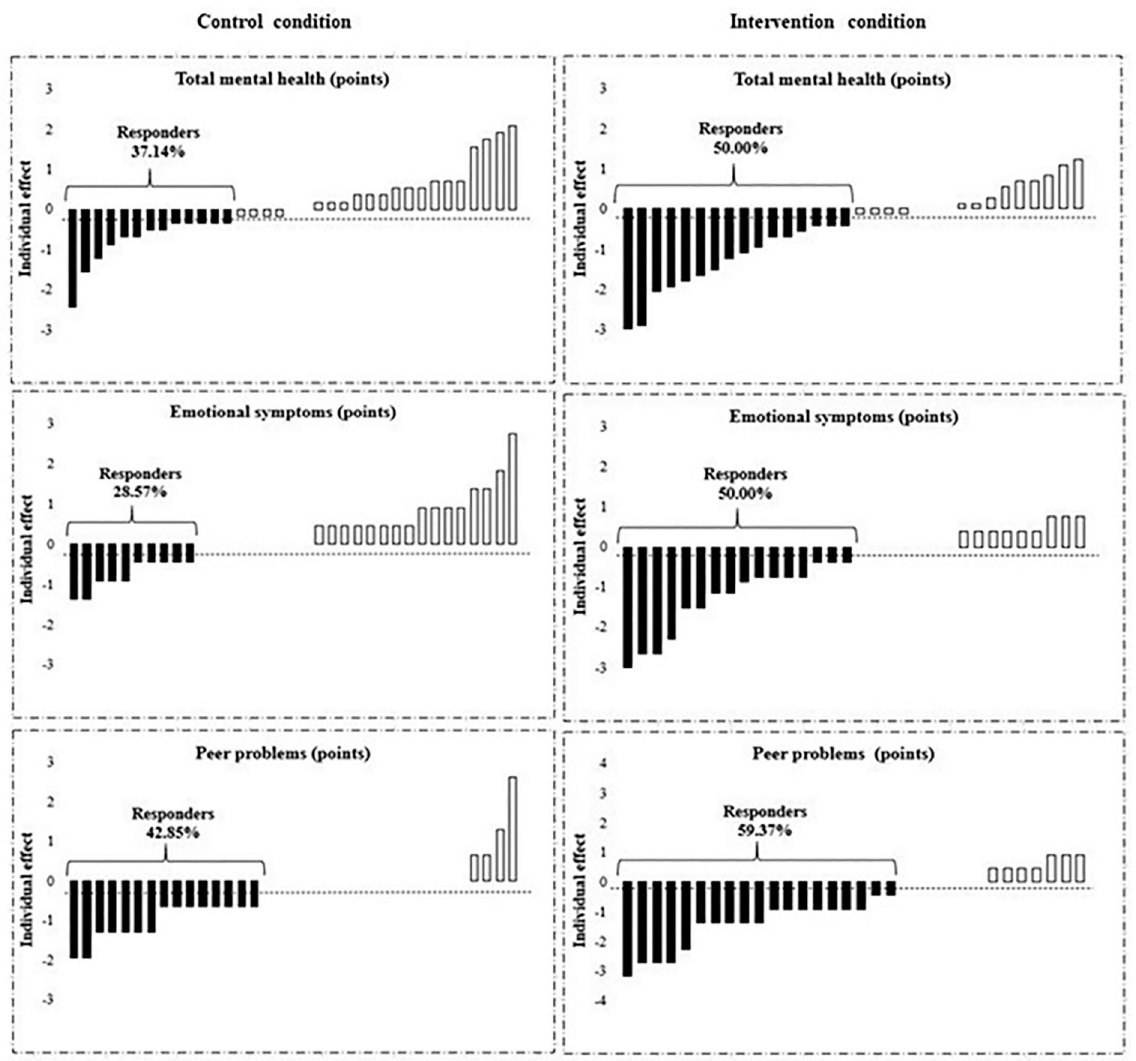
Figure 3 - Prevalence of responders in intervention and control conditions after physical education programs at school in the total mental health and scale